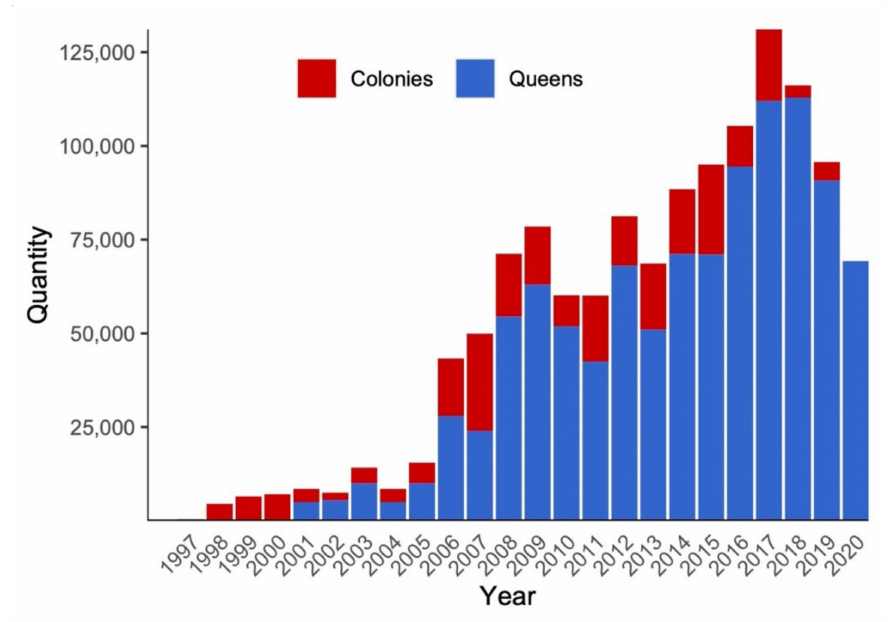
Figure 3. Bombus terrestris colonies and queens imported to Chile from 1997 to 2020